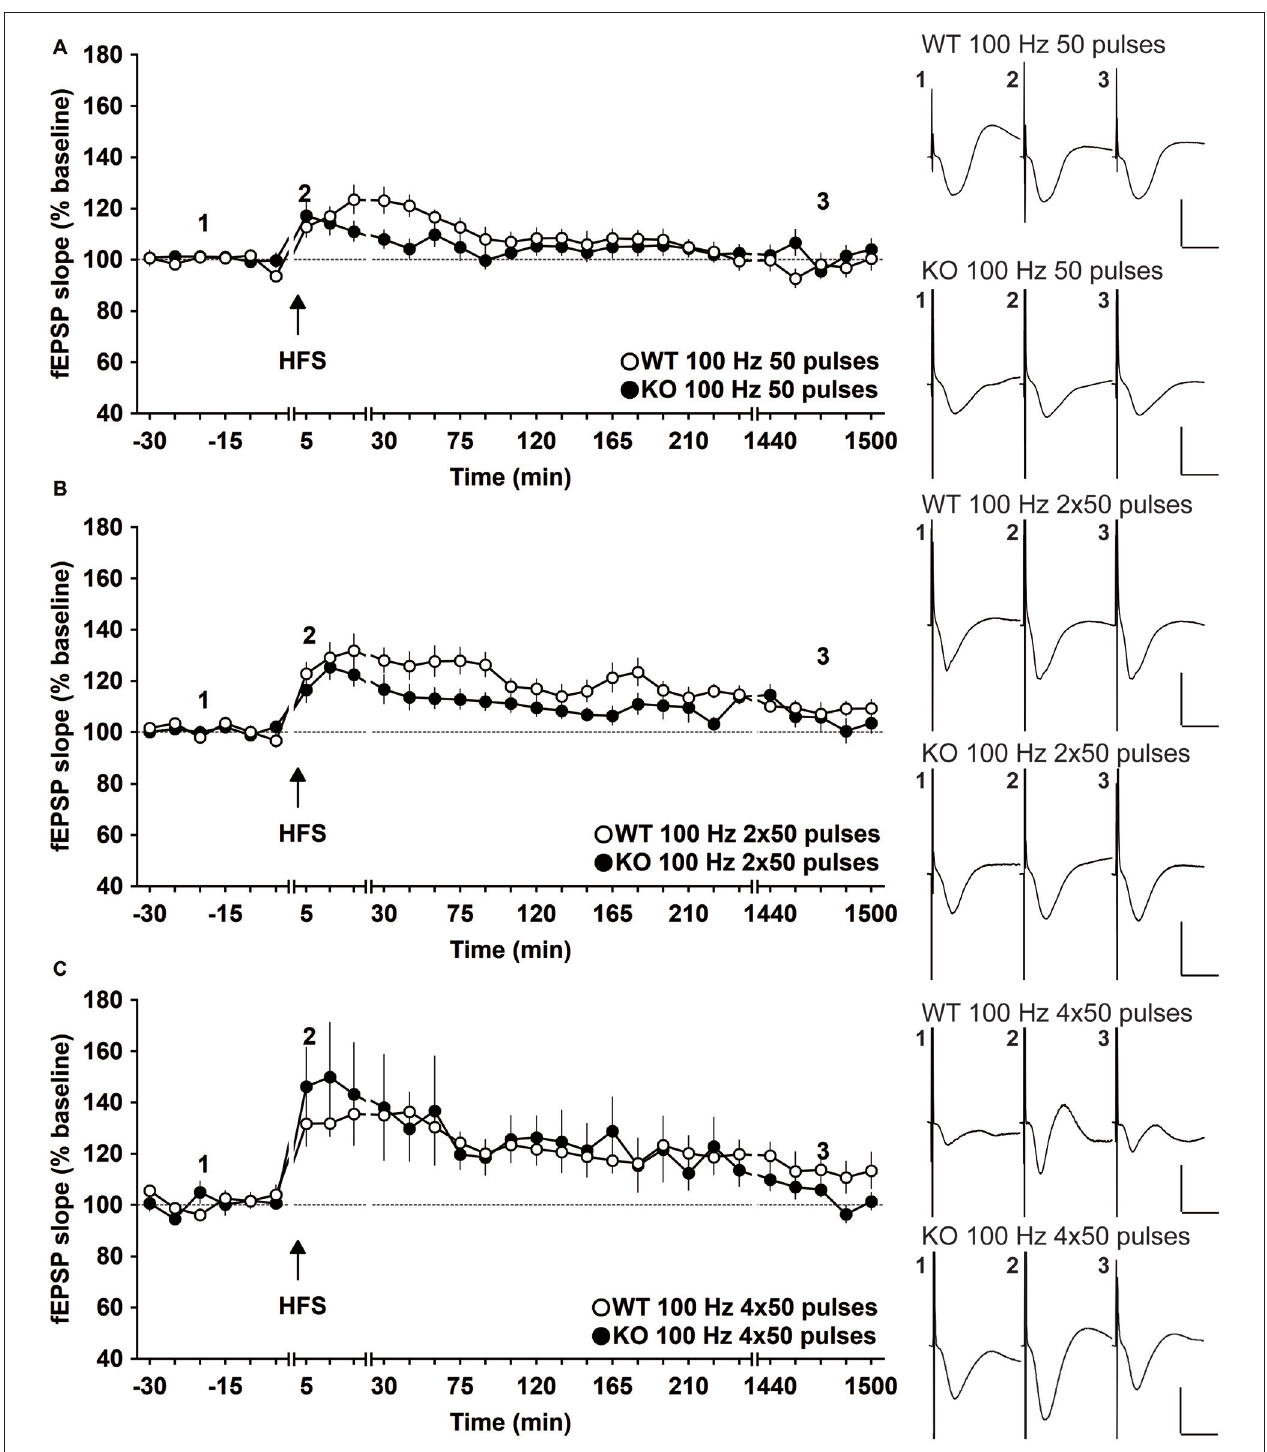
FIGURE 2 | Early-long-term potentiation (E-LTP) is impaired, whereas LTP and late-LTP (L-LTP) are unaltered in freely behaving GluN2A-KO mice. (A) High-frequency stimulation (HFS) comprising 50 pulses at 100 Hz evokes significant E-LTP ( < 1 h) in WT mice. The same protocol, when given to GluN2A-KO mice, results in a significant impairment of E-LTP. (B) HFS comprising 100 Hz, given as two bursts of 50 pulses, induces robust LTP (2–4 h) in both WT and KO mice. (C) A stronger HFS that comprises 100 Hz, given as four bursts of 50 pulses induces L-LTP, ( > 24 h) in WT mice. KO animals respond to this protocol with L-LTP that is not significantly different to WT L-LTP. Insets: examples of fEPSPs evoked at the time-points indicated by the numbers. Horizontal scale bar: 10 ms, vertical scale bar: 2 mV.